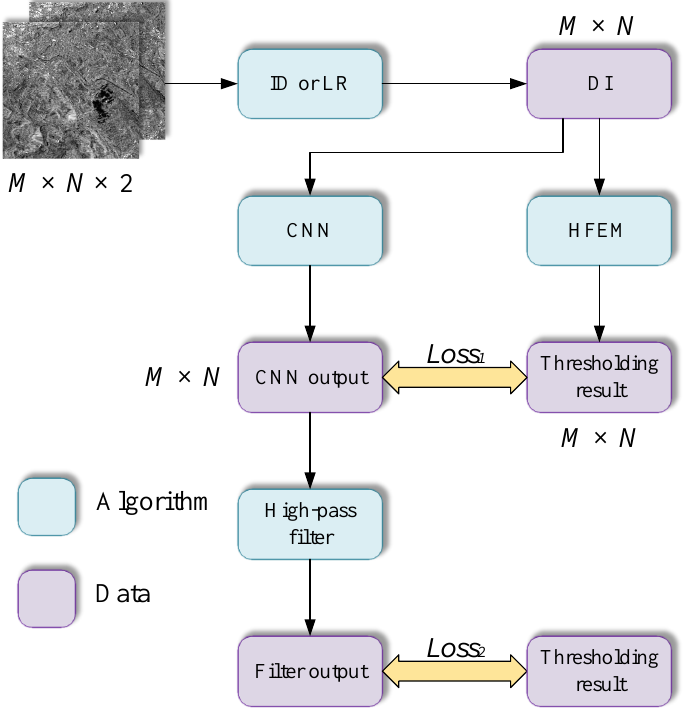
Figure 3. The framework of the proposed change detection